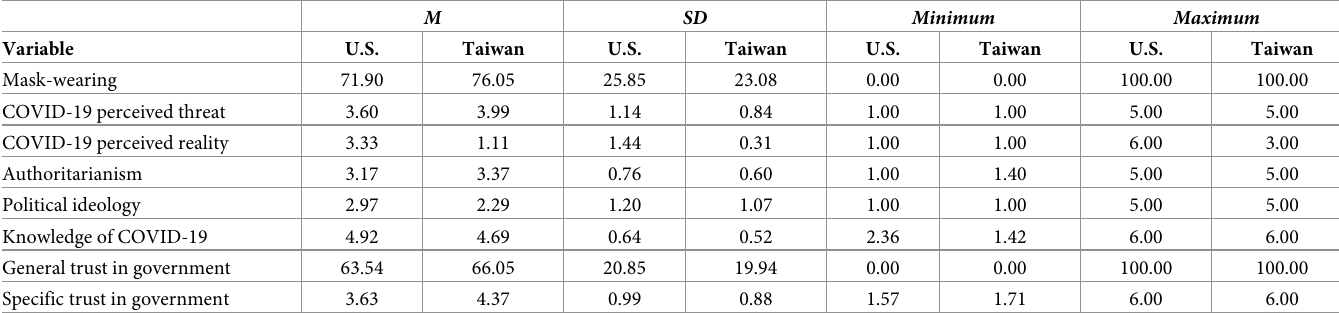
Table 3. Descriptive statistics for U.S. and Taiwan samples.